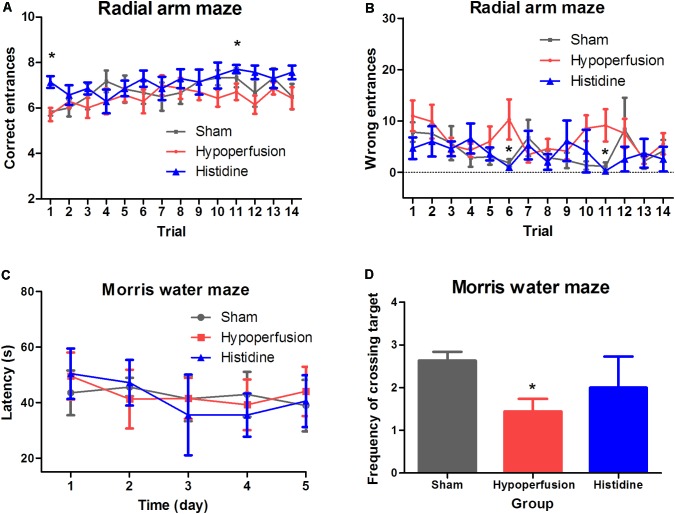
Effects of histidine on the cognitive dysfunctions induced by hypoperfusion. (A) The frequency of correct entrance was increased significantly after histidine administration (n = 6, ∗p < 0.05 compared with Hypoperfusion group). (B) The frequency of wrong entrance was decreased significantly after histidine administration (n = 6, ∗p < 0.05 compared with Hypoperfusion group). (C) The escape latencies of reaching the platform in Morris water maze showed no significant changes among the three groups (n = 6). (D) The frequency of crossing target was decreased significantly in Hypoperfusion group (n = 6, ∗p < 0.05 compared with Sham operation group). Histidine promoted the recovery of the decreased frequency after hypoperfusion slightly without significant difference.